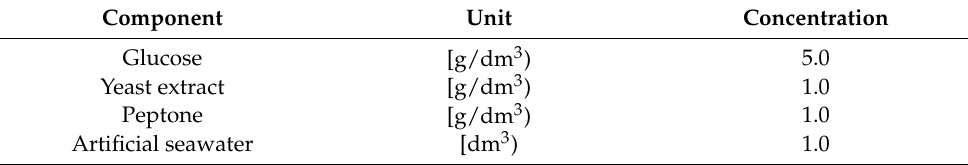
Table 1. Composition of ATCC790 By+ culture medium used in the experiment.